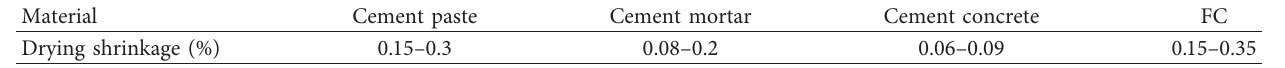
Table 1: The drying shrinkage values observed in typical cement-based materials [85].